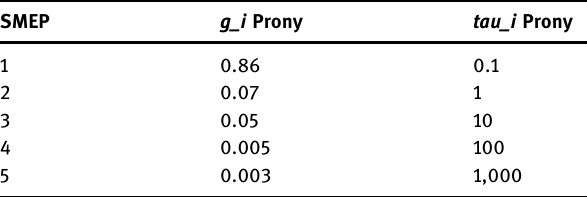
Table 2: Fitting results of viscoelastic model